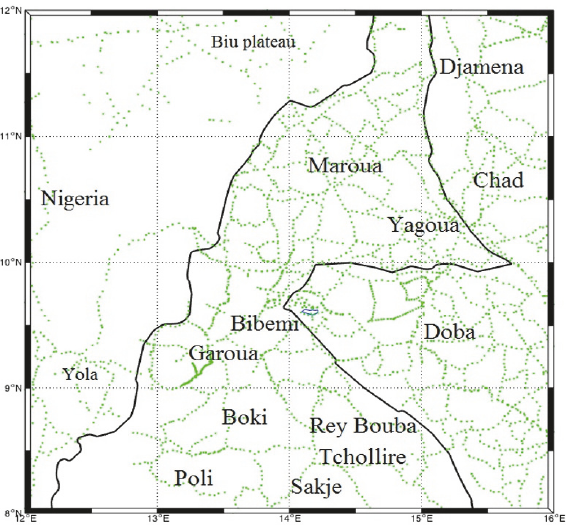
Figure 1: Spatial distribution in the study area.